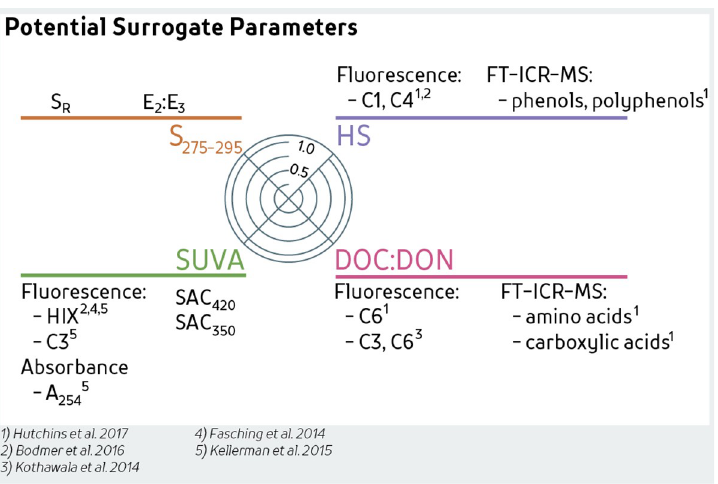
Fig 7. Surrogate parameters for the DOM composition